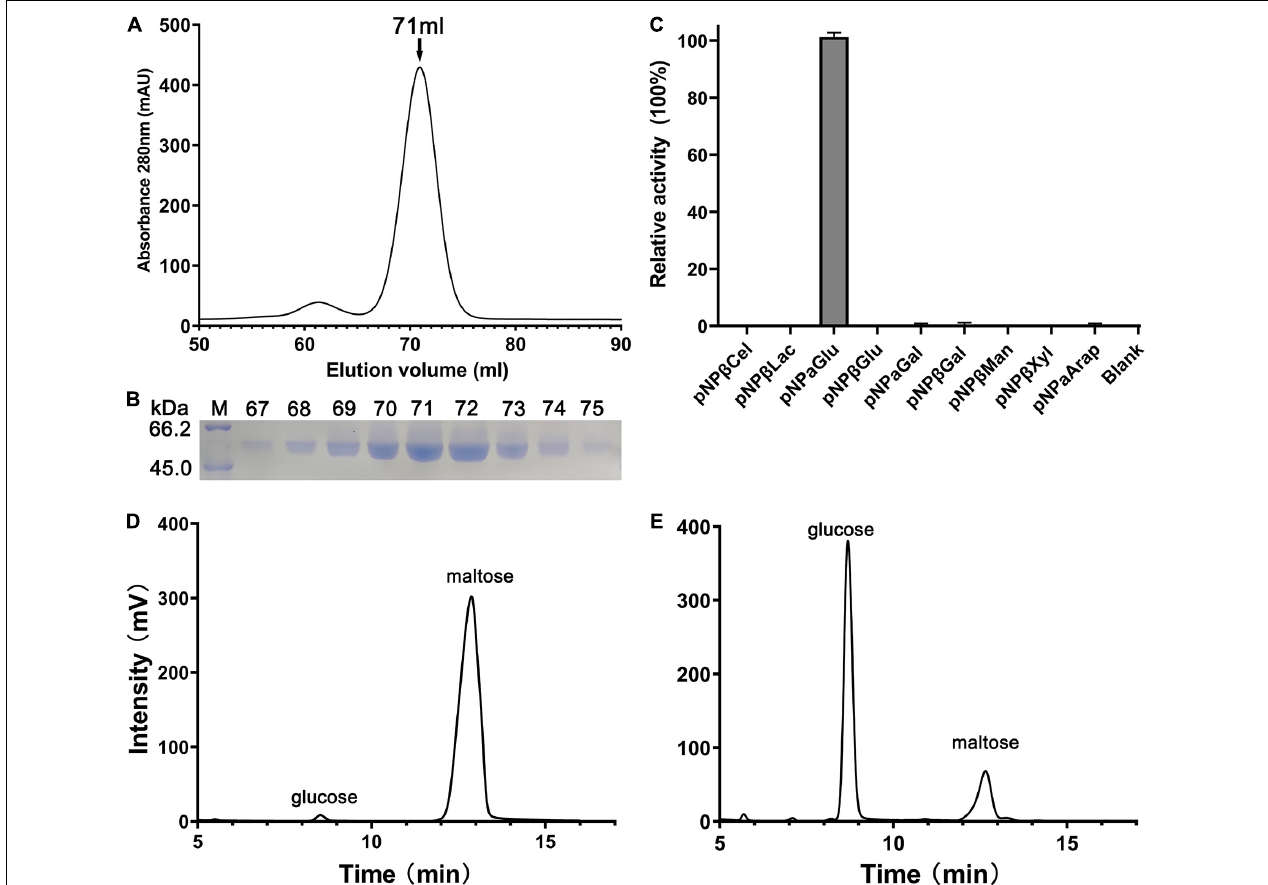
FIGURE 1 | Purification and substrate specificity of QsGH13. (A) The QsGH13 protein was purified by gel-filtration chromatography, and it was eluted at the peak of 71 ml. (B) The QsGH13 protein was determined by SDS-PAGE. (C) The substrate specificity of the enzyme was determined using different substrates. (D,E) The enzymatic activities of QsGH13 toward maltose was determined by HPLC. Maltose (substrate) and glucose (product) came out at the peak positions of 12.723 and 8.831 min, respectively. Panel (D) is before the reaction, and Panel (E) is after the reaction.